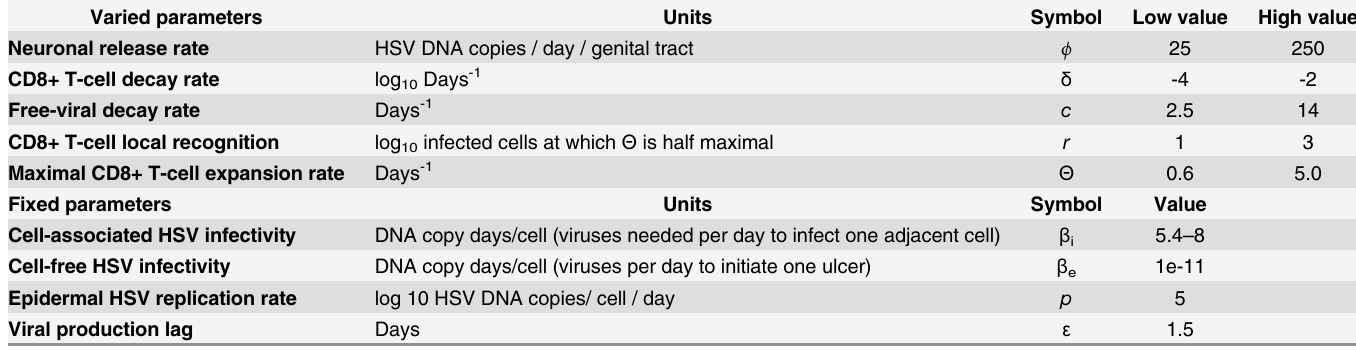
Table 3. Parameter ranges used for model fitting. Varied parameters were selected from uniform distributions. Fixed parameters were derived from prior model fitting or literature search (Methods). Varied